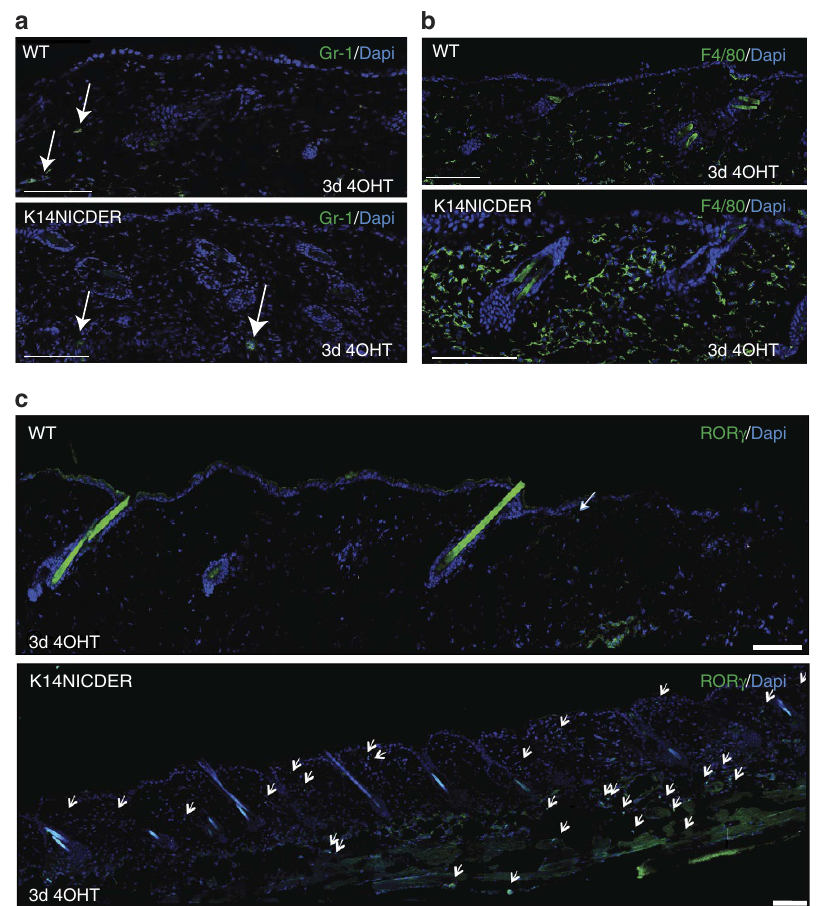
Figure 3 | Epidermal Notch activation drives dermal recruitment of ILC3s and F4/80 þ macrophages. Back skin sections of K14NICDER transgenic and littermate control mice treated with 4OHT for 3days and stained with antibodies to Gr-1 ( a , green), F4/80 ( b , green) or ROR g ( c , green). White arrows mark either Gr-1 þ ( a ) or ROR g þ ( c ) cells. Note rare Gr-1 þ neutrophils ( a , white arrows) were detected in transgenic and control mice, however F4/80 þ ( b ) and ROR g þ ( c , white arrows) cells are abundant in stained K14NICDER back skin sections; scale bars equal 100microns; experiments were repeated Z 3